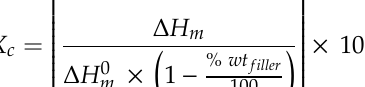
Figure 6. DSC thermograms of melting of ( a ) PCL, ( b ) PCL/APIBPOSS ‐ 2, ( c ) PCL/APIBPOSS ‐ 5, ( d ) PCL/APIBPOSS ‐ 10, ( e ), PCL/APIOPOSS ‐ 2 ( f ) PCL/APIOPOSS ‐ 5, and ( g ) PCL/APIOPOSS ‐ 10 nanocomposites obtained during heating at 10 °C min − 1 after non ‐ isothermal crystallization at the indicated cooling rates.